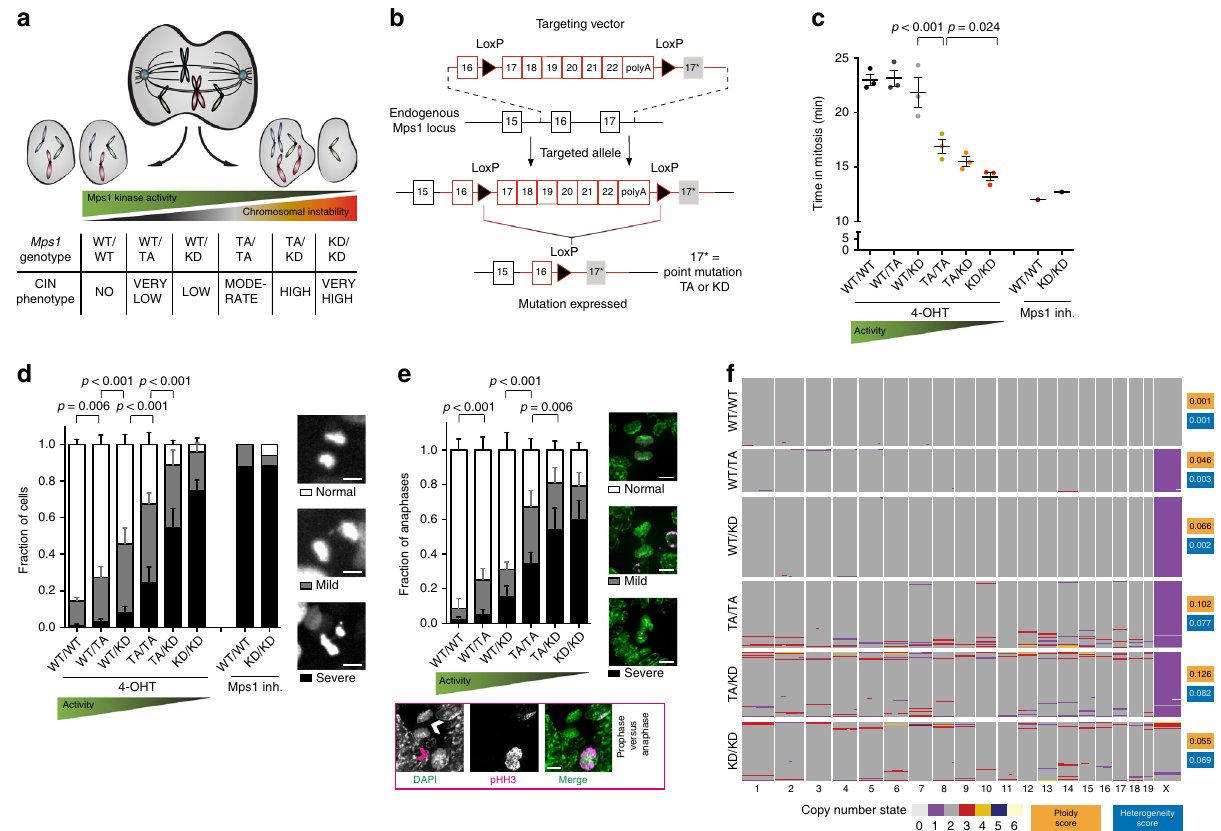
Fig. 1 An allelic series for graded increases in CIN in vivo. a Theoretical inverse correlation of decreased spindle assembly checkpoint function with increased severity of CIN. b Overview of the CiMKi alleles: the targeting vectors harbor a cDNA cassette of wild-type (WT) exons 17 – 22, fl anked by lox-P sites, and the mutated exon 17* (TA or KD). In the targeted CiMKi alleles, wild-type Mps1 is replaced with mutant Mps1 upon Cre-mediated loxP recombination. c Quanti fi cation of time in mitosis (prophase to anaphase) by time lapse imaging of immortalized MEFs of the CiMKi;Rosa26-CreER T2 genotypes 56 h after 4-OHT addition. DNA was visualized by H2B-mNeon. Two independent untreated lines ( CiMKi WT/WT and CiMKi KD/KD , both expressing wild-type Mps1 ) were treated with MPS1 inhibitor CPD5. Error bars indicate ± SEM of three independent MEF lines per genotype; 50 cell divisions per line. See also Supplementary Movies 1, 2. d Quanti fi cation of chromosome segregation fi delity of samples described in c . Missegregations of chromosomes were categorized as indicated: severe ( ≥ three), mild (one or two). Scale bars 5 μ m. See also Supplementary Movies 1, 2. Analysis as in c . e Chromosome segregation fi delity in situ in small intestine of CiMKi;Rosa26-CreER T2 mice one week after tamoxifen injection. DAPI (green) and anti- phospho-Histone H3 (Ser10) (pHH3; magenta) were used to identify anaphases (white arrowhead; weak staining) and prophases (magenta